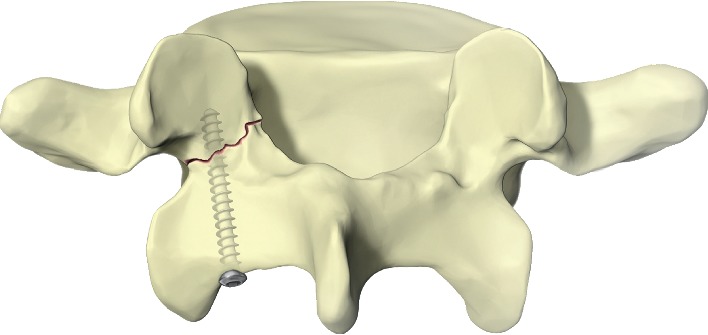
Lag screw technique.